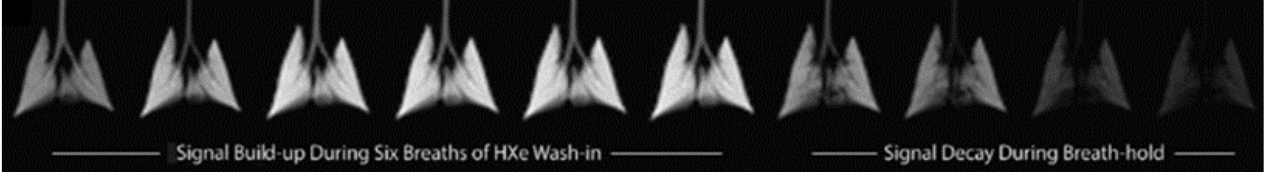
Figure 5. A series of 6 wash-in breaths of 70%/30% HXe/O 2 is followed by four images acquired over a 12-second breath hold in a horizontal slice in a healthy rabbit. Washin dynamics illustrate the uniformity of signal buildup arising from uniform ventilatory gas exchange efficiency characteristic of health. Images acquired at breath-hold show some shrinkage of the lung as xenon is taken up into the bloodstream, and nonuniformity of decay representing inhomogeneous oxygen concentrations, particularly in the large airways and posterior azygous